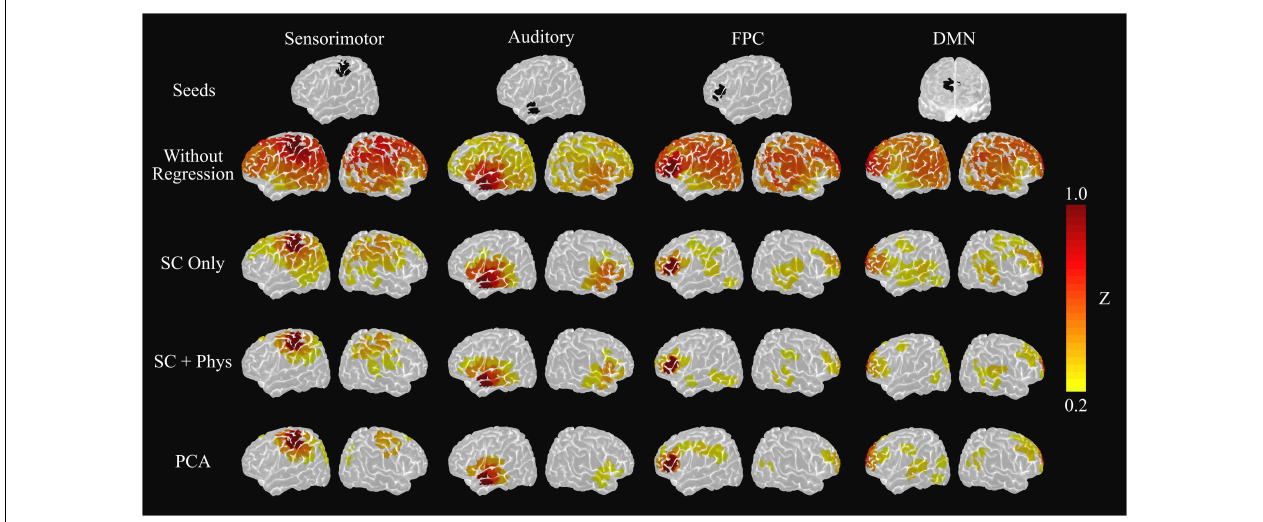
FIGURE 4 | Group level sensorimotor, auditory, frontoparietal control (FPC) and default mode network (DMN) seed-based networks extracted from the average HbT correlation matrix. The top row shows the location of the seed used to extract each map. The following rows represent the resulting networks after using a given method to remove systemic physiology, including PCA regression after removing the first principal component. The removal of systemic physiology better localizes the networks and increases the agreement with the fMRI